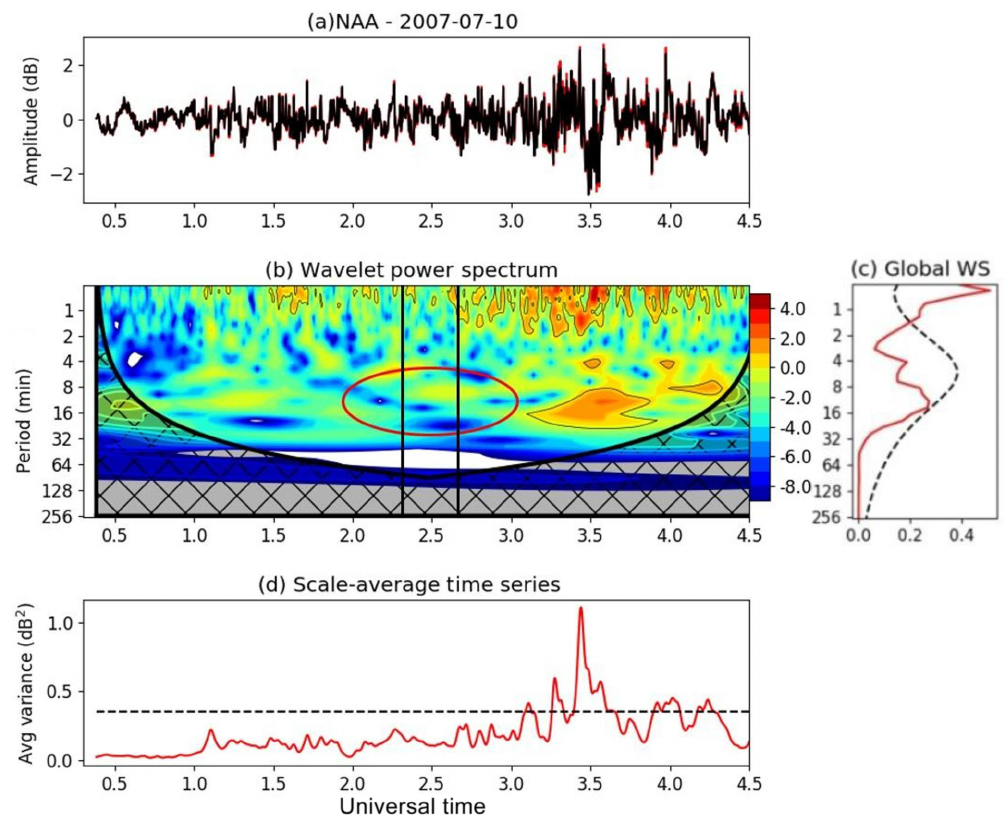
Figure 5. Same as Fig. 4, but for the VLF signal propagating in the NAA–Atibaia VLF